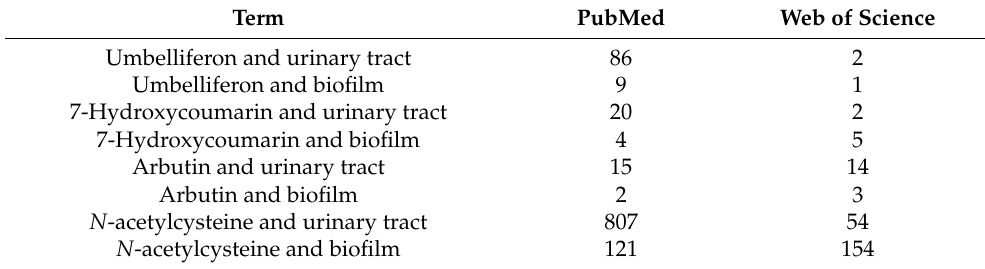
Table 1. Results of database search. Term PubMed Web of Science